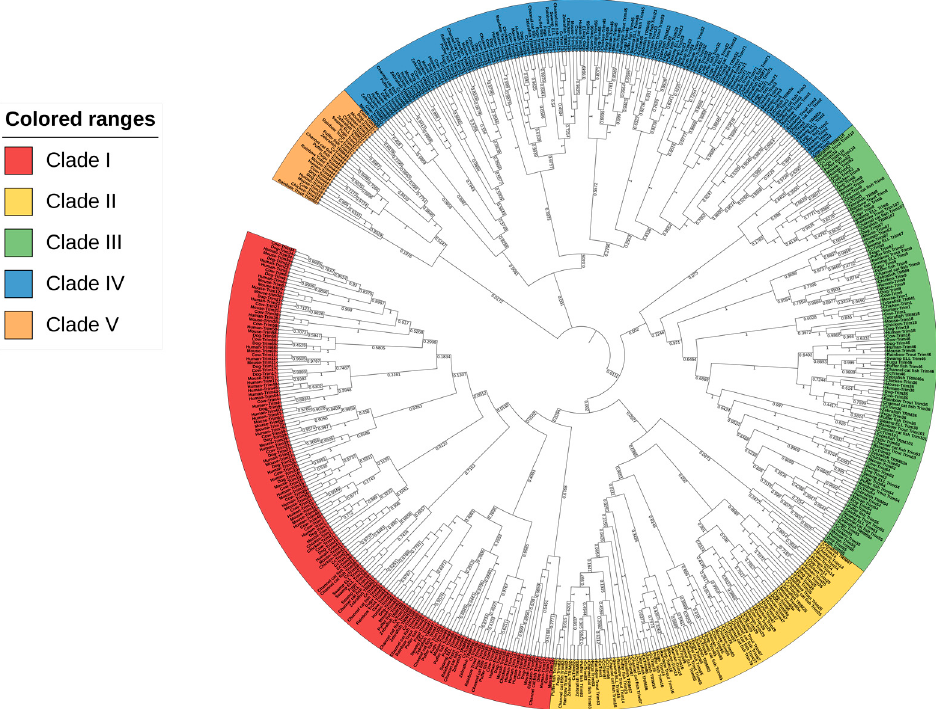
Figure 1. Global phylogenetic analysis of the full-length sequence of TRIM proteins from teleost species (common carp, zebrafish, fugu, pufferfish, channel catfish, rainbow trout and swamp eel) and tetrapods (Human, Mouse, Cow, Cat, Dog, and Chicken). MEGAX was used to construct a phylogenetic tree by using neighbor-joining (NJ) method and a bootstrap value of 1000 replicates. The phylogenetic tree is divided into five different groups based on clades of TRIM proteins. Each group was marked with unique